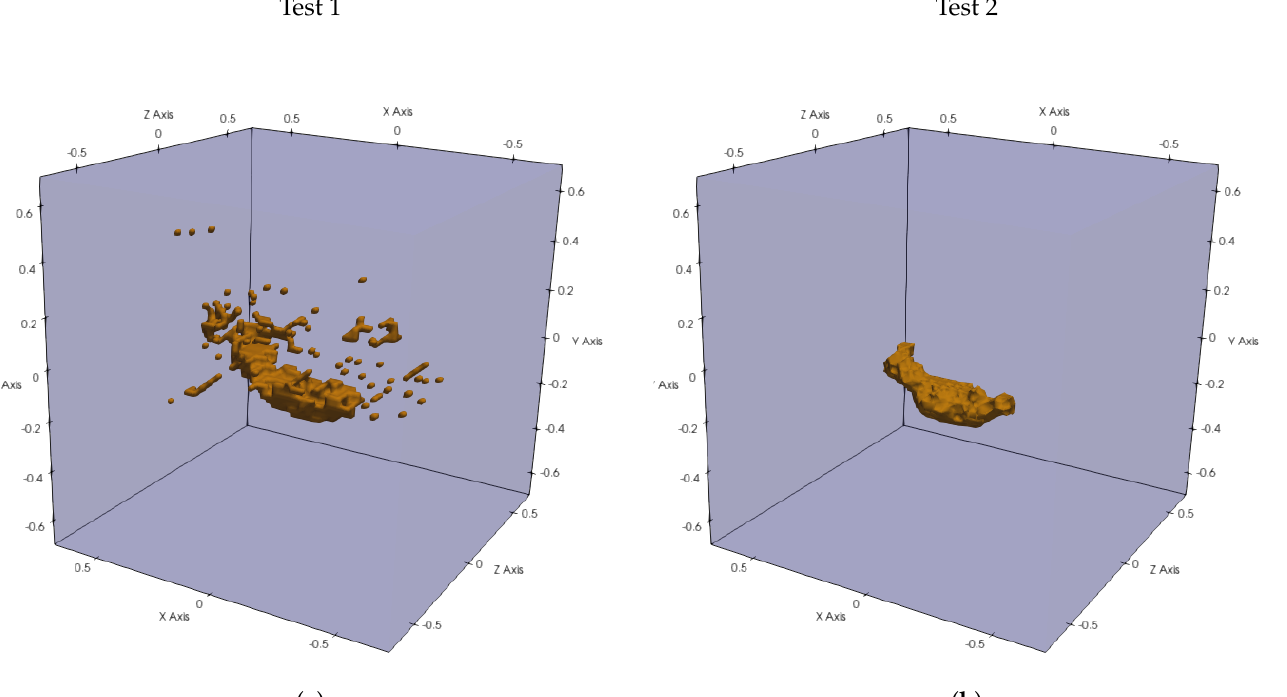
5 corresponding ≈